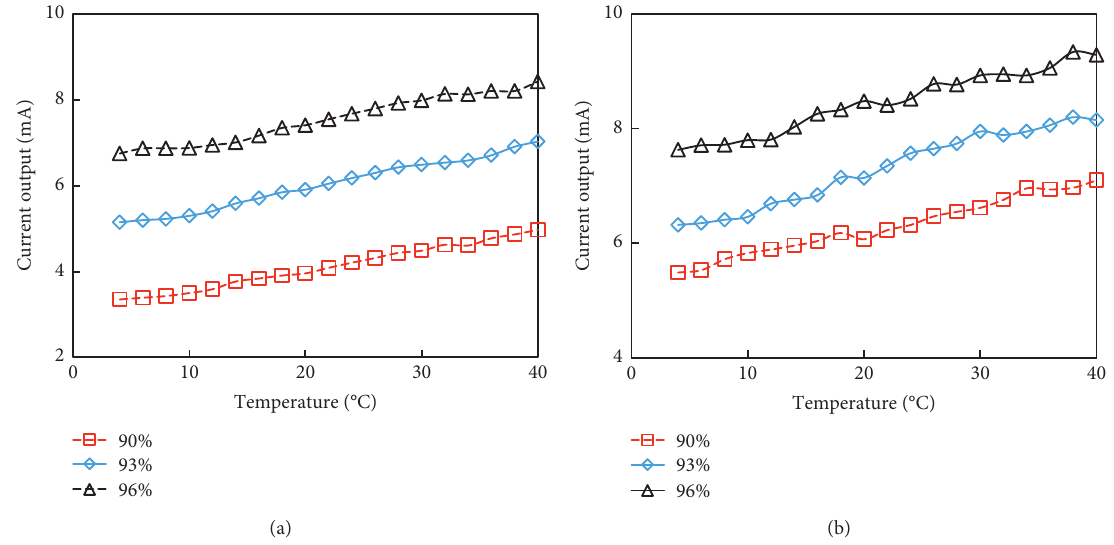
Figure 5: Influence of temperature on TDR sensor test results at the moisture of (a) 10.11%; (b) 18.83%.